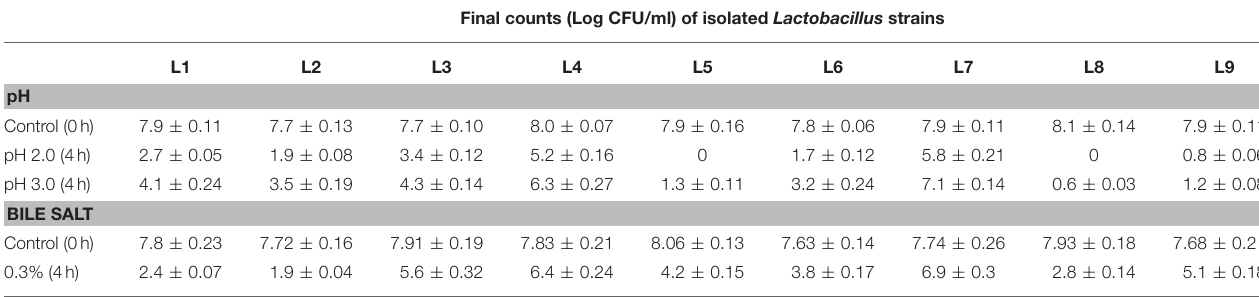
TABLE 1 | Assessment of viability of isolated strains to low pH and bile salts during 4h of